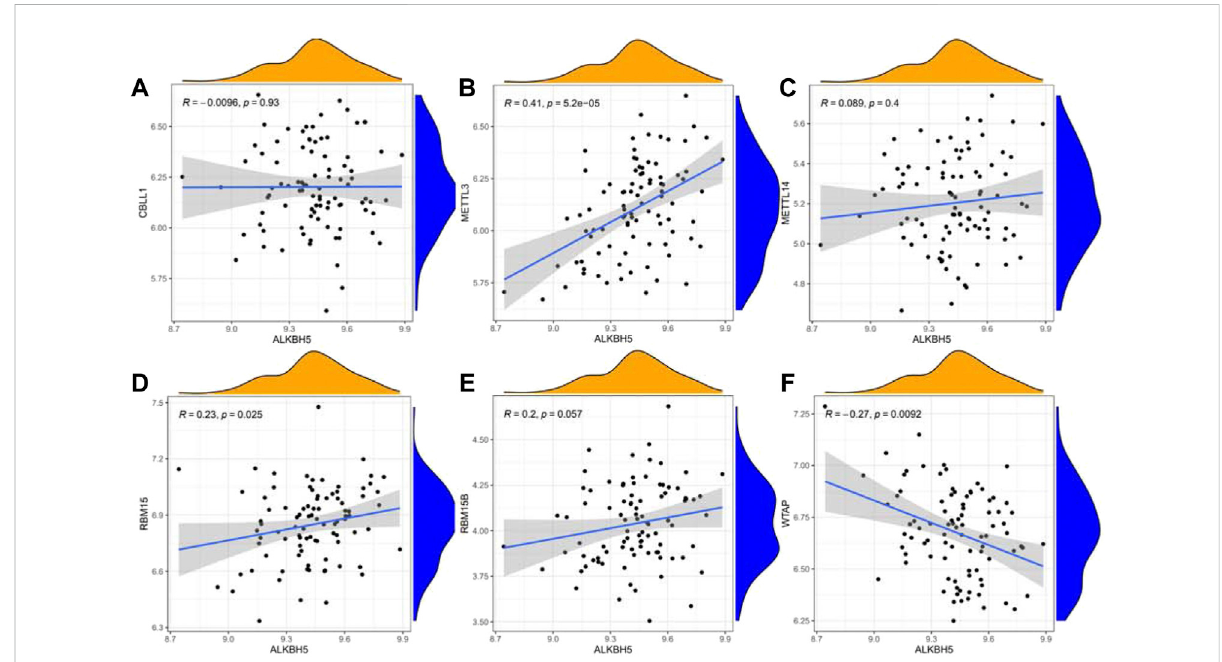
FIGURE 2 Linear regression analyses shows the correlation between one eraser gene and six writer genes in epilepsy (A – F) . Eraser gene: ALKBH5. Writer genes: CBLL1, METTL3, METTL14, RBM15, RBM15B, and